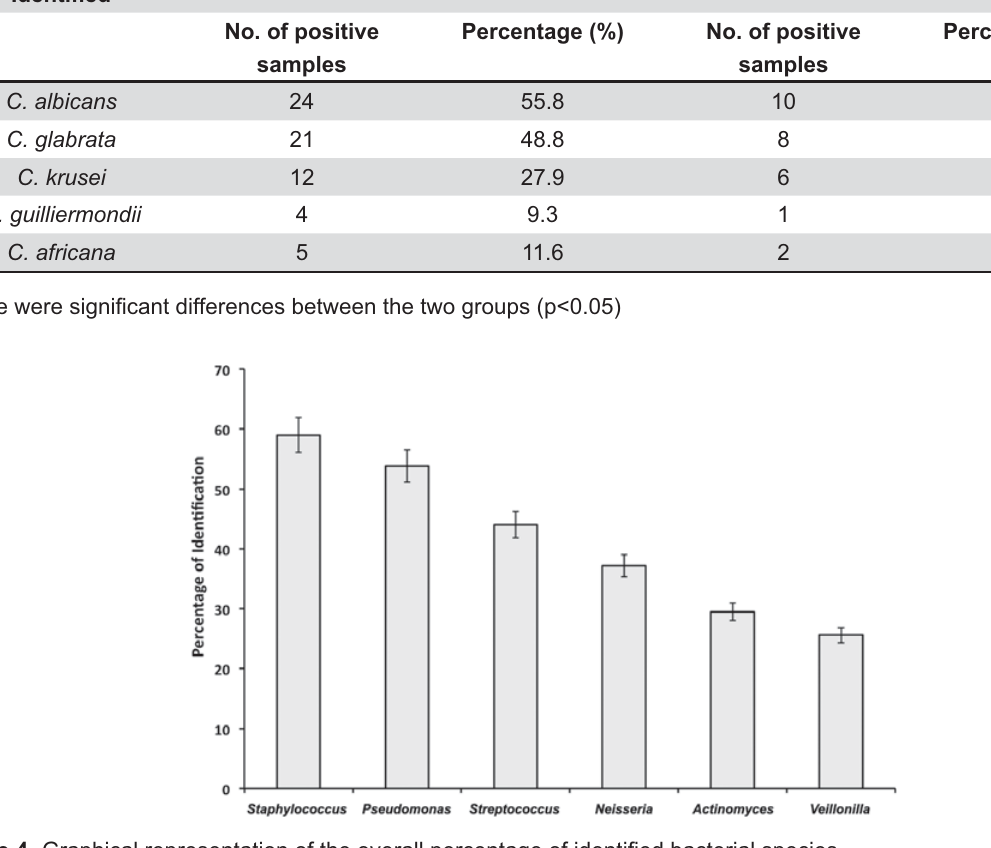
Figure 4- (cid:19)(cid:20)(cid:7)(cid:18)(cid:16)(cid:21)(cid:12)(cid:8)(cid:18)(cid:22)(cid:19)(cid:7)(cid:14)(cid:16)(cid:7)(cid:14)(cid:11)(cid:14)(cid:13)(cid:10)(cid:18)(cid:10)(cid:12)(cid:6)(cid:13)(cid:19)(cid:6)(cid:23)(cid:19)(cid:10)(cid:21)(cid:14)(cid:19)(cid:6)(cid:28)(cid:14)(cid:7)(cid:18)(cid:22)(cid:22)(cid:19)(cid:16)(cid:14)(cid:7)(cid:8)(cid:14)(cid:13)(cid:10)(cid:18)(cid:24)(cid:14)(cid:19)(cid:6)(cid:23)(cid:19)(cid:12)(cid:25)(cid:14)(cid:13)(cid:10)(cid:12)(cid:26)(cid:14)(cid:25)(cid:19)(cid:29)(cid:18)(cid:8)(cid:10)(cid:14)(cid:7)(cid:12)(cid:18)(cid:22)(cid:19)(cid:11)(cid:16)(cid:14)(cid:8)(cid:12)(cid:14)(cid:11)